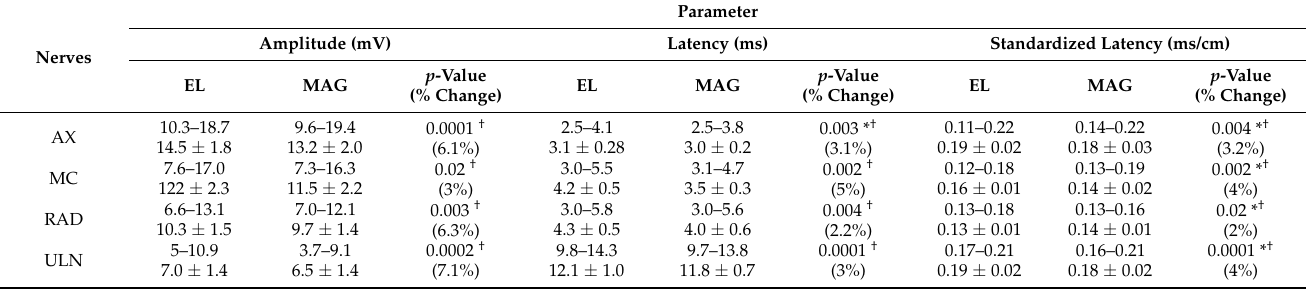
Table 4. Data of evoked potentials following application of two types of stimulation (magnetic and electrical) at Erb’s point ( n = 84). Ranges, means, and standard deviations are presented. † Significant p -values at <0.05.